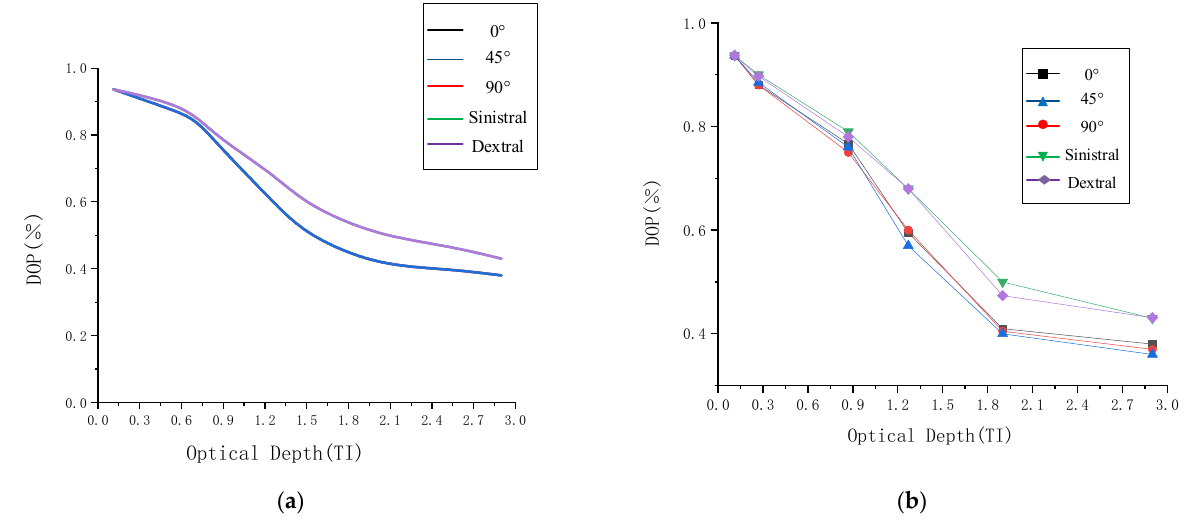
Figure 9. λ = Simulation and experimental comparison of DOP change of 532 nm polarized light: ( a ) simulation results and ( b ) experimental results.